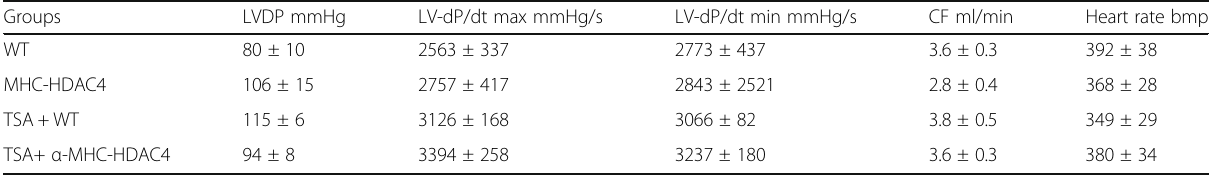
Table 1 Baseline ventricular function in Langendorff hearts Groups